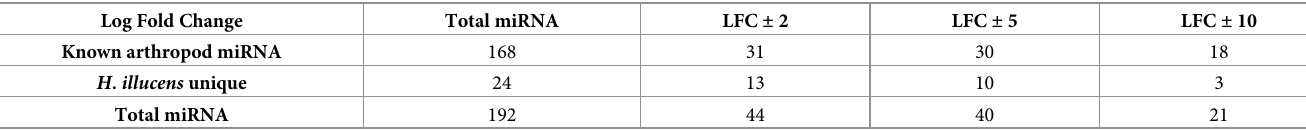
Table 3. Summary of microRNAs differential expression log fold change (LFC).